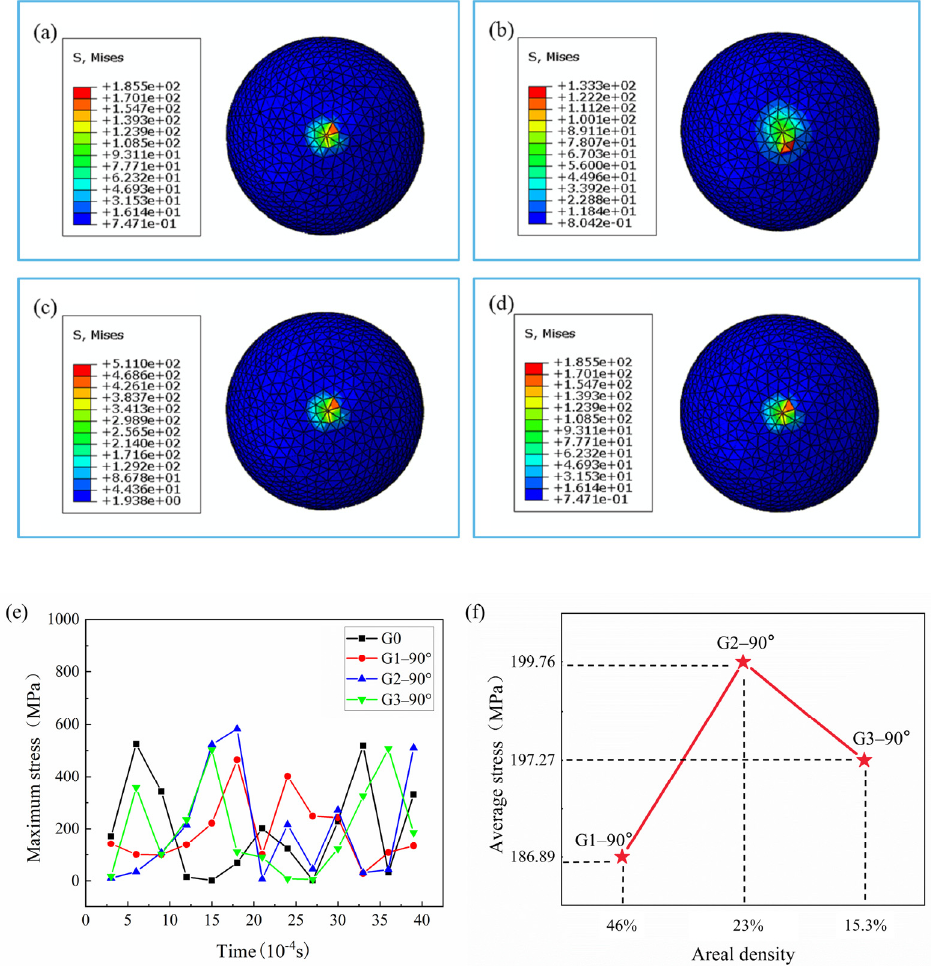
Figure 6. Simulation results of the stress field of TC4 sliding with the ( a ) G0, ( b ) G1, ( c ) G2, and ( d ) G3 samples. ( e ) Maximum stress distribution curves and ( f ) the relationship between the areal density and average stress of TC4 when the sliding direction was perpendicular to the groove textures.